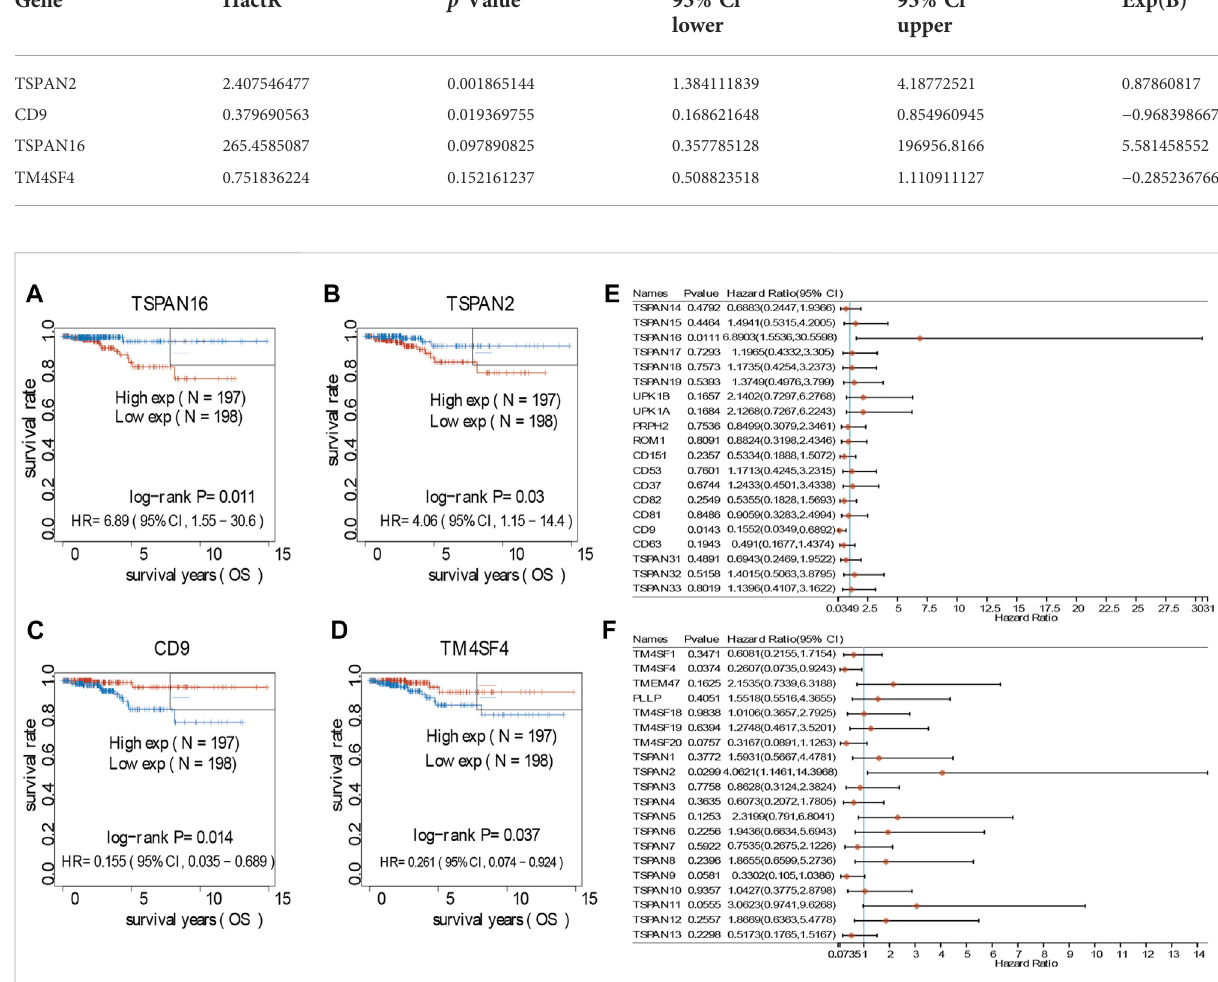
TABLE 1 Multivariable cox regression analysis for CD9, TM4SF4, TSPAN2, and TSPAN16. Gene